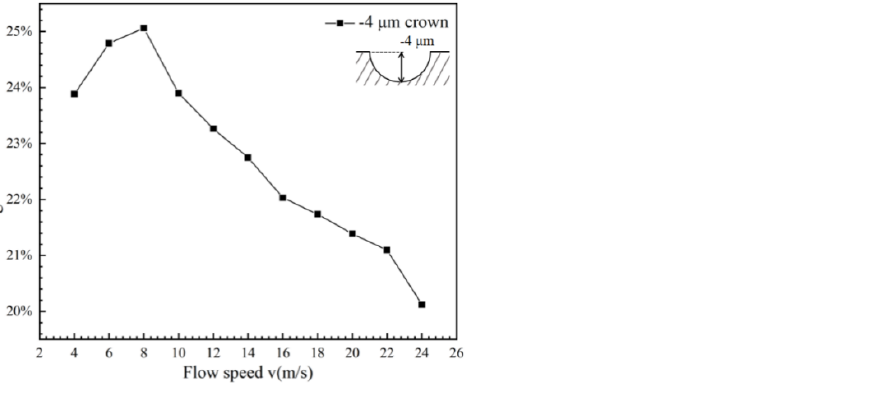
Figure 12. ( a ) Flow velocity curve of the surface of the negative spherical cap structure along with flow velocity, and ( b ) a variation of the turbulent flow energy intensity of negative spherical crown surface. In the field of hydrokinetics, it is well known that the wall surface resistance is mainly composed of two aspects of friction of vortexes with the surface and the pressure re- sistance of the water with the surface. Because of the existence of riblets, vortexes locate above the groove, interacting only with the peak of the grooved surface, and lateral flow velocity pulsation in the groove is much smaller than the lateral flow of riblets’ top [13]. In this paper, the flowing water in the groove valley is relatively close to the state of lam- inar flow. Due to the existence of a negative spherical crown, the momentum exchange at the bottom of the groove valley further reduces, which led to the reduction of friction resistance on the groove surface. In addition, vortexes form in negative spherical crown effectively convert the sliding friction between water flow and the wall surface into rolling friction, which also reduces the friction resistance from another aspect. It is generally believed that the increase in wetting area in the groove surface struc- ture increases the pressure resistance [10], but this mechanism has been changed due to the negative crown microstructure on the surface of the V-shaped groove. It is also men- tioned earlier that the turbulent kinetic energy on the surface with a spherical crown in- dicates the boundary layer is conformable to the laminar structure. According to Ber- noulli’s theorem, for the flowing water which is on the near-surface, the higher the veloc- ity, the lower the pressure. In the situation of the negative crown, the pressure resistance is much smaller than the theoretical growth pressure resistance which is caused by the increase in the effective contact area. So, the negative spherical crown microstructure on the surface of the V-shaped groove effectively reduces the resistance from both the fric- tional resistance and the pressure resistance. Because of this, the drag reduction effect of the negative crown microstructure is beyond expectations in this paper.